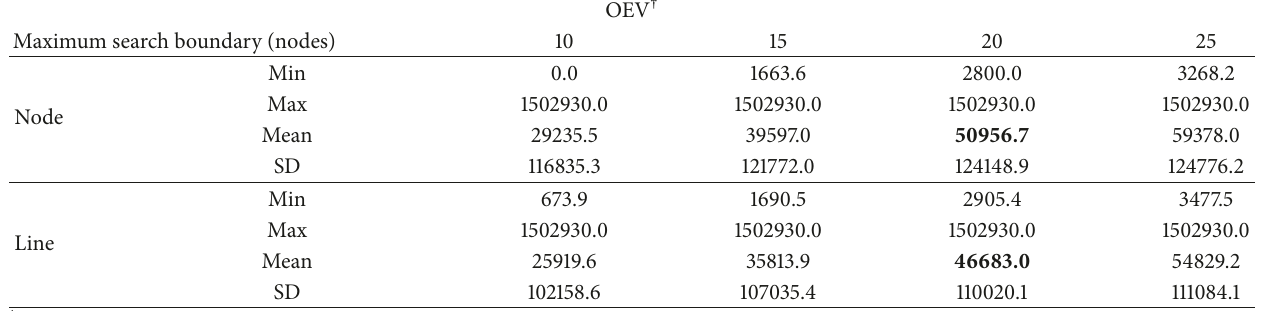
Table 1: Statistics of OEV in relation to the maximum search boundary in the study area.